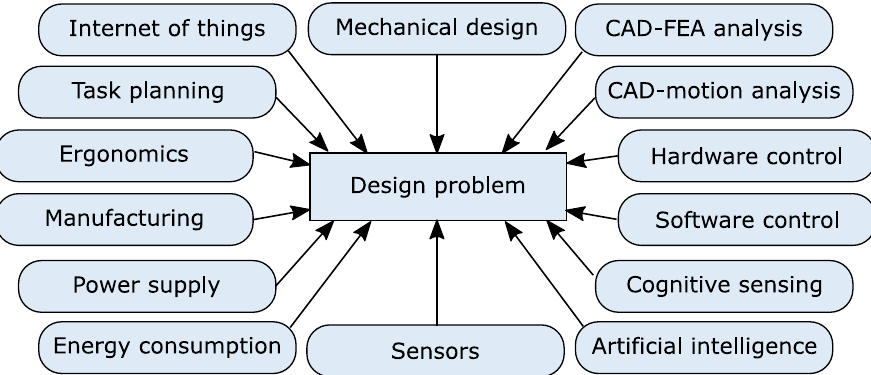
Figure 2. A scheme for conceptual design problem in